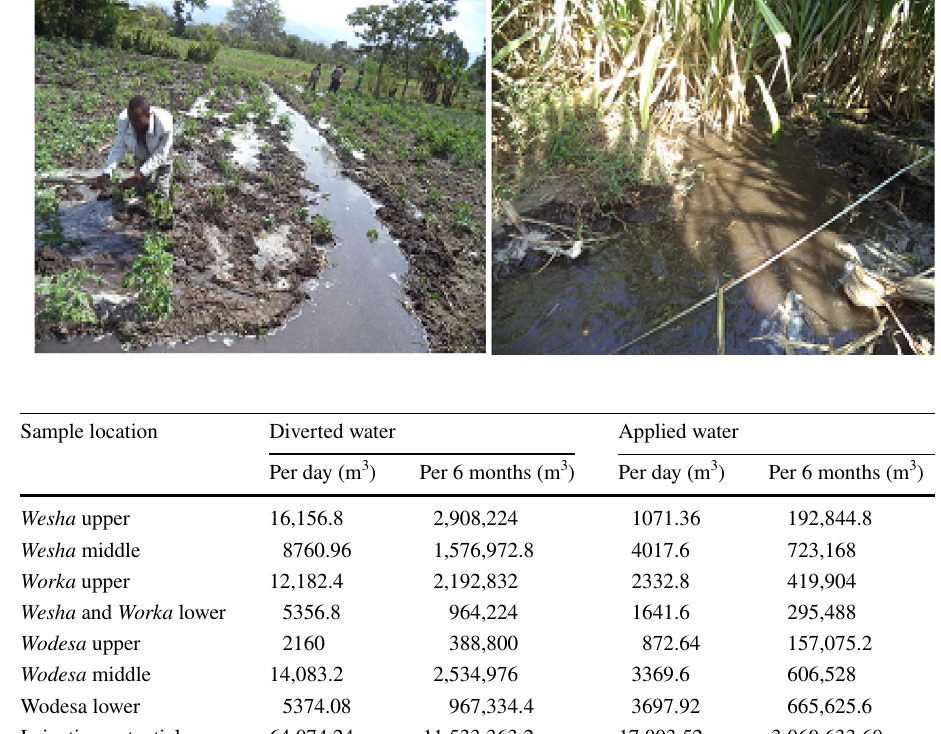
Fig. 3 Traditional surface irri- gation water application systems of farmers